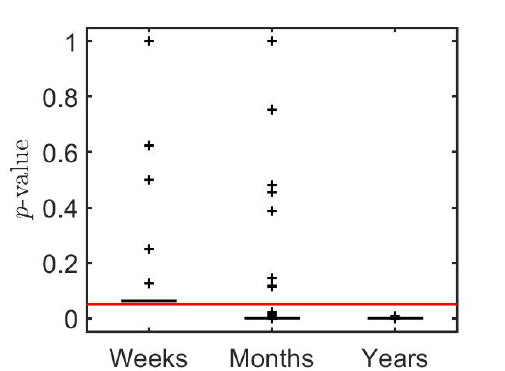
Figure 3. Box-whisker plots of the p -values for two-sided sign tests on the values of ˆ p n ∆ t of the SPY daily log-returns shown in Figure 2. The solid red line indicates the 0.05 significance level.